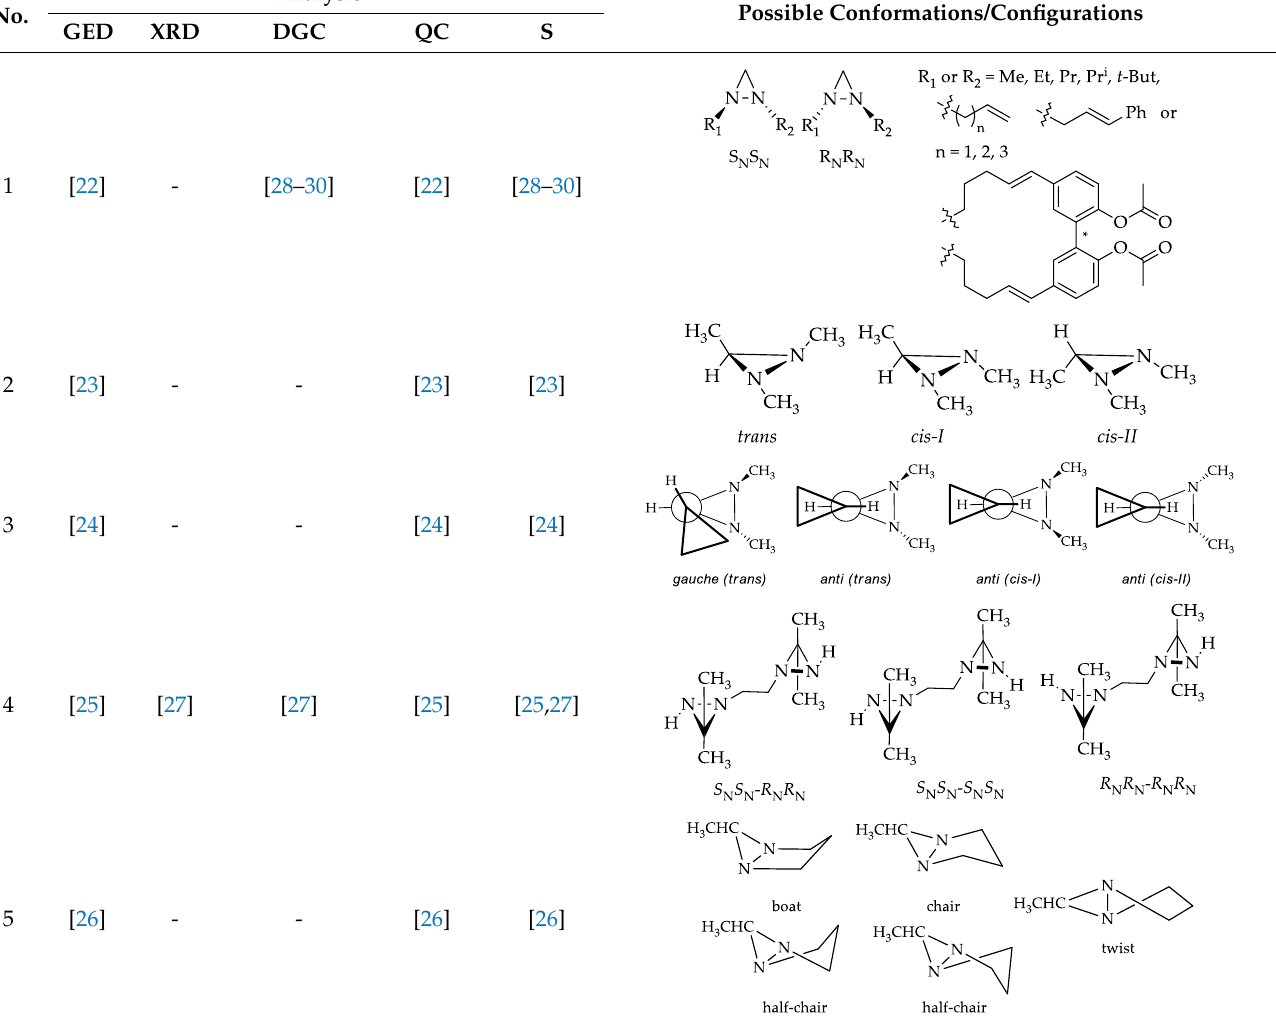
Table 1. Recent experimental structure identification studies of diaziridine derivatives.